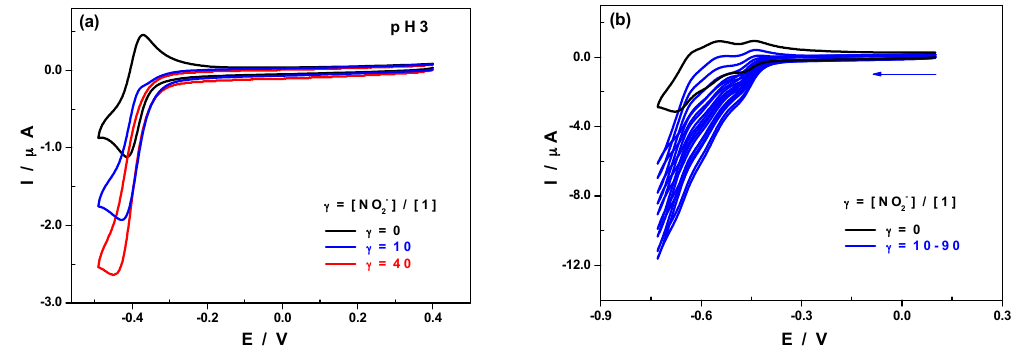
Figure 4. CVs of 1 in absence and in presence of increasing amounts of nitrite, ( a ) in 0.5 M Li 2 SO 4 + H 2 SO 4 /pH 3 and ( b ) in 1.0M CH 3 COOLi + CH 3 COOH/pH 4. Polyoxometalate concentration: 0.5 mM; scan rate: 10 mV · s − 1 ; working electrode: glassy carbon; reference electrode: SCE. The excess parameter − ]/[ 1 γ is defined as γ = [NO 2